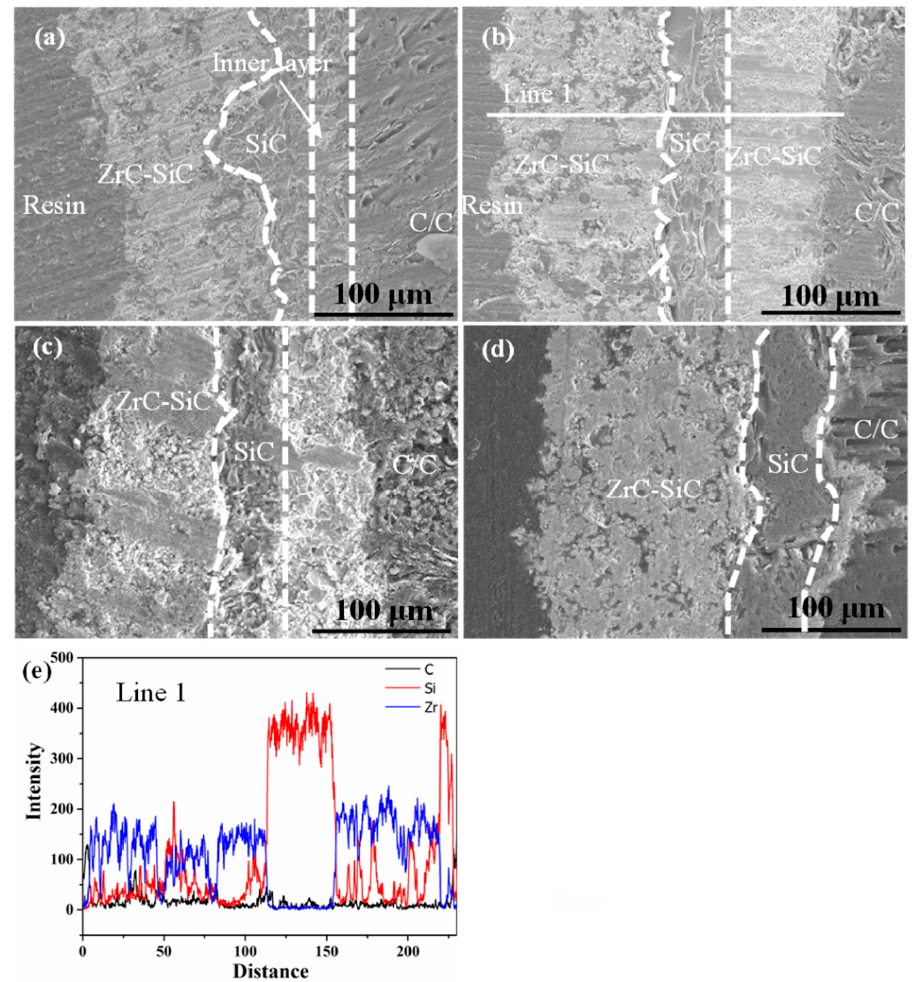
Figure 9. Cross-sectional SEM images and line scanning of the prepared S3 coatings. ( a ) S3-A; ( b ) S3-B; ( c ) S3-C; ( d ) S3-D; ( e ) the line scanning of line 1 in Figure b.